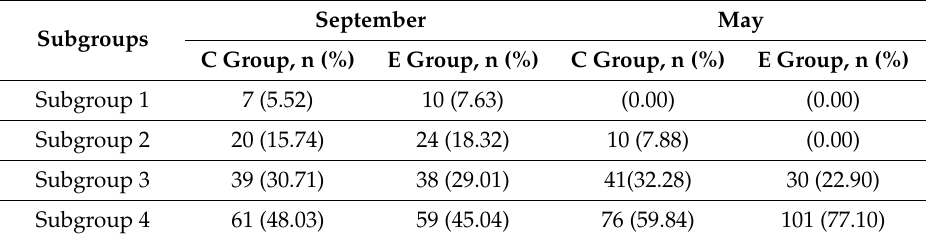
Table 1. The number of students in the control (C) and experimental (E) groups (in proportion to the total number of students in the control and experimental groups) who were unable to solve any of the three alphanumeric problems (subgroup 1), those who solved one problem (subgroup 2), those who solved two problems (subgroup 3) and those who solved three problems (subgroup 4) in September and